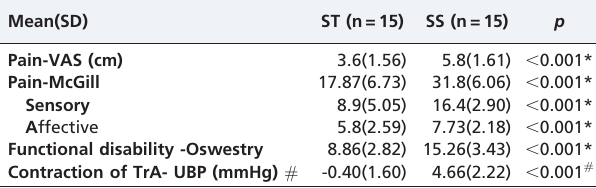
Table 5 - Mean Gain (difference of before and after in each group), and p